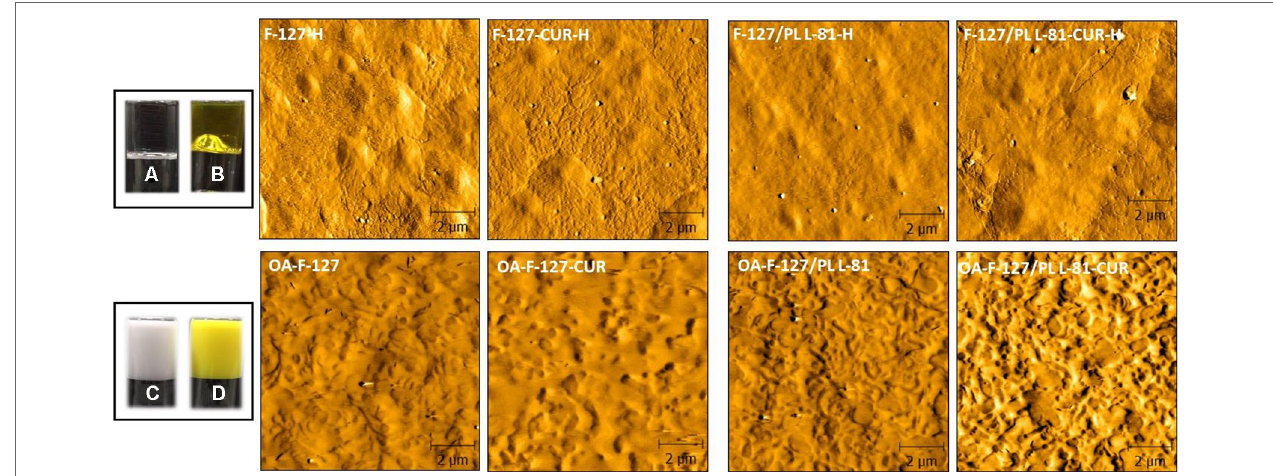
FIGURE 1 | Micrographs for organogels and hydrogel formulations obtained from atomic force microscopy (AFM). (A) F-127/L-81-H, (B) F-127/L-81-CUR-H, (C) OA-F-127/L-81, and (D) OA-F-127/L-81-CUR. H—indicates hydrogel formulations (without oleic acid). OA, oleic acid; F-127, Pluronic ® F-127; L-81, Pluronic ® L-81; CUR,